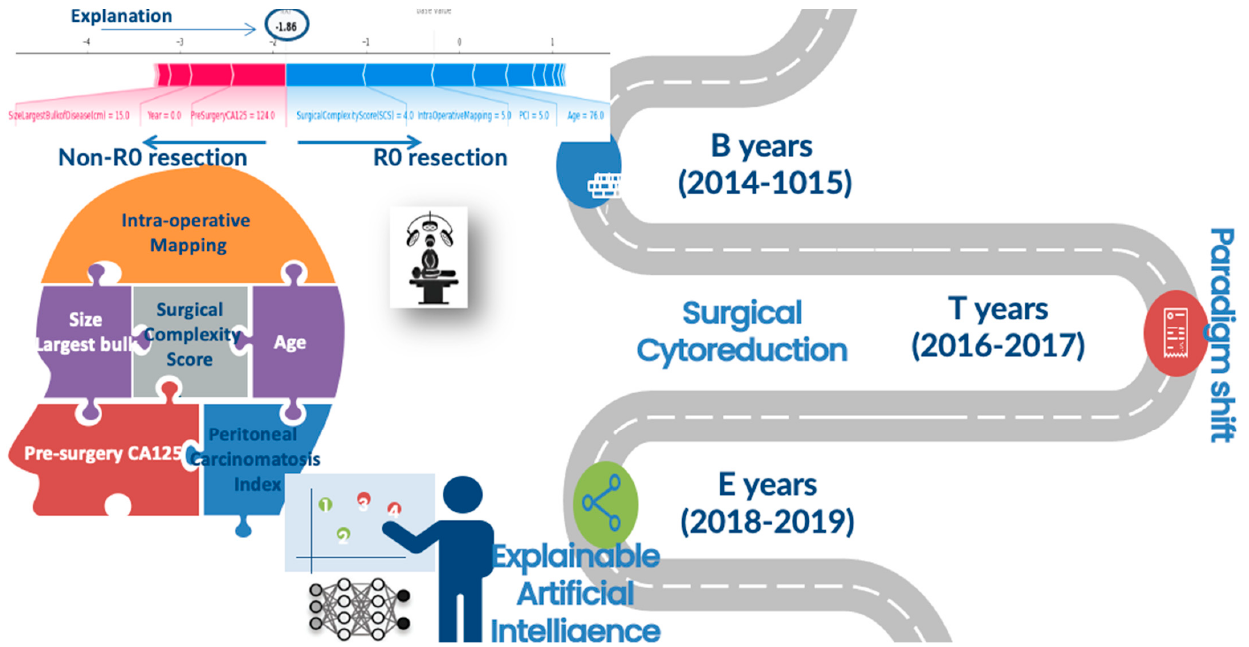
Figure 6. Distribution of features for global and local explainability of an AI-based model for prediction of complete cytoreduction in EOC patients. B; baseline, T; transition, E; evaluation.